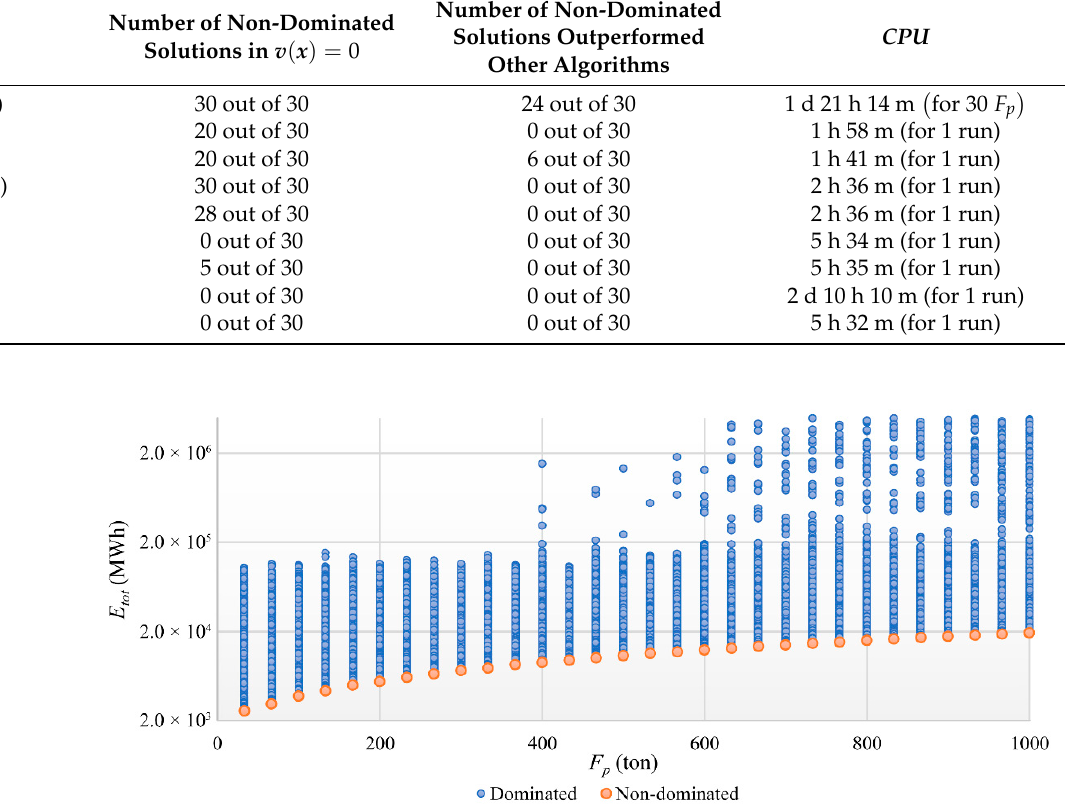
Figure 22. Search space and optimisation results of jEDE for stepwise run.